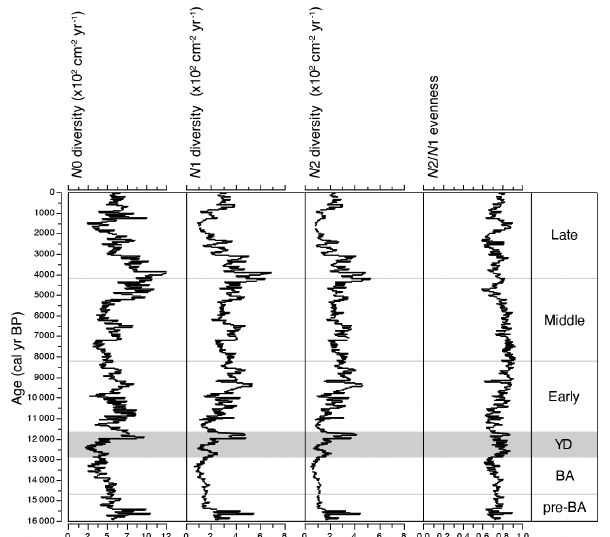
Figure 4. Comparison of Hill’s richness ( N 0), diversity ( N 1 and N 2), and evenness ( N 2 /N 1 ratio) trends over the past ca. 16kyr. Richness and diversity values were further divided by sediment ac- cumulation rates over time, so these measures become estimated Hill’s numbers per cm − 2 yr − 1